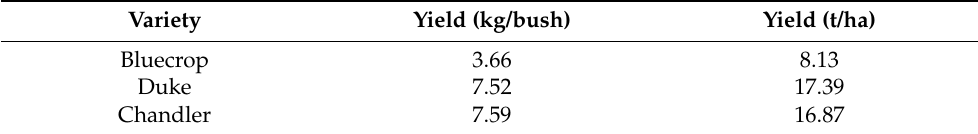
Table 3. Average yield per bush (kg) and unit area